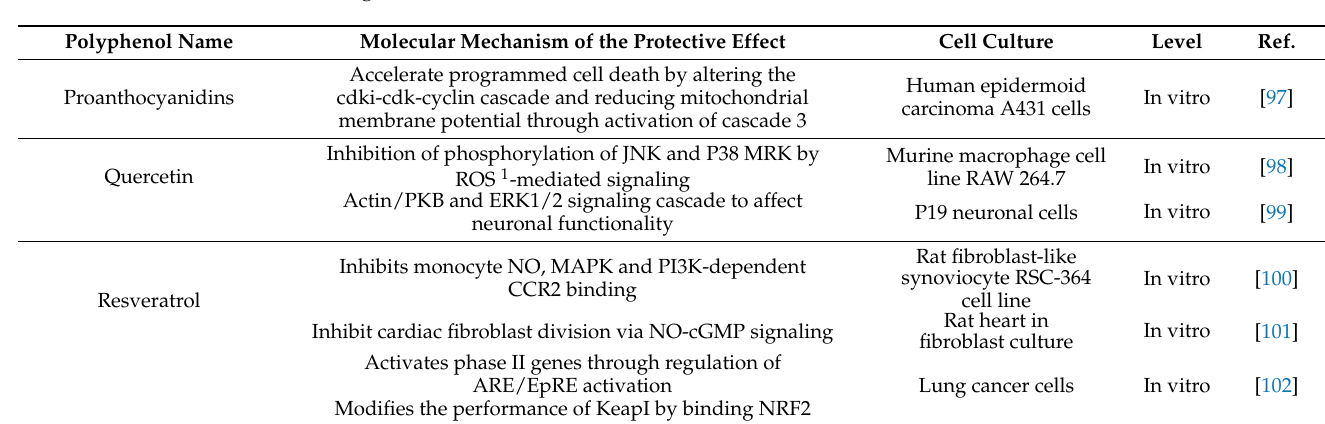
Table 10. Effect of the polyphenol content of grape marc (grape seeds and skins) on signal